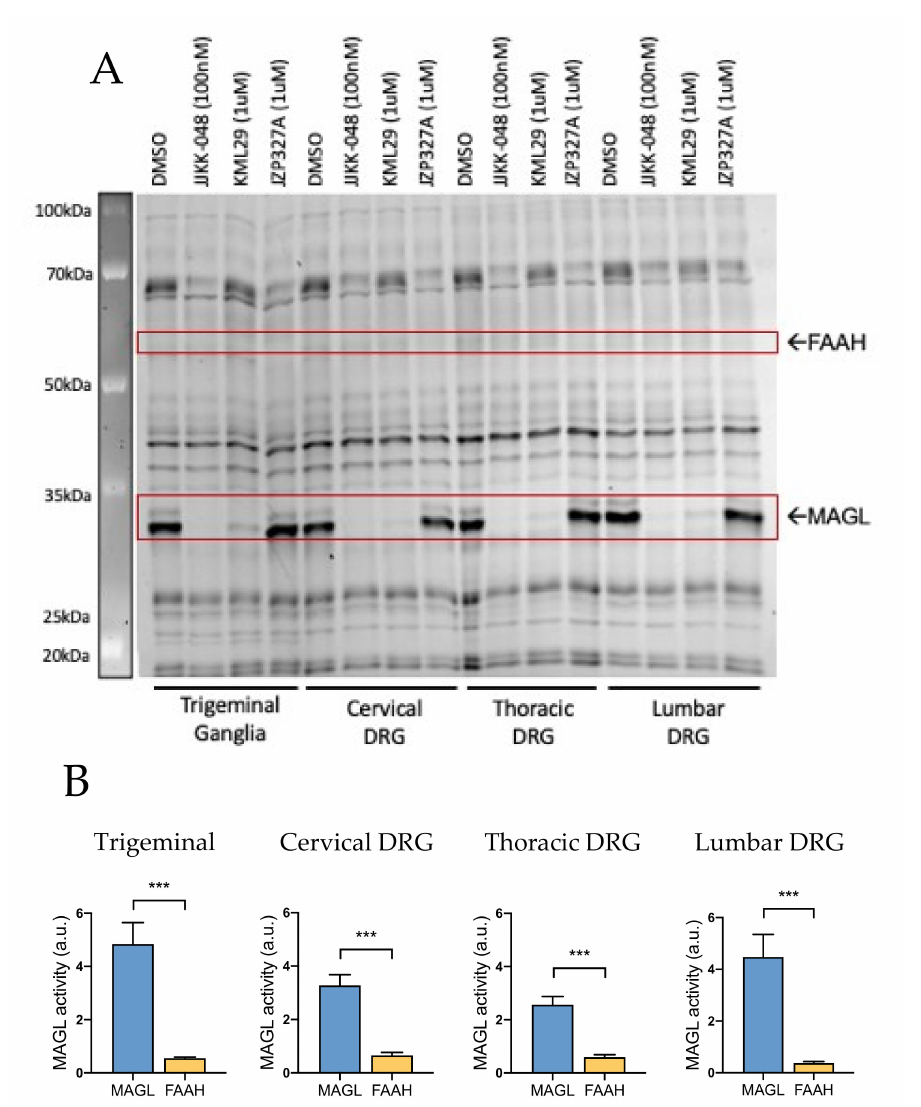
Figure 1. Competitive gel-based activity-based protein profiling (ABPP) reveals higher monoacyl- glycerol lipase (MAGL) activity over fatty acid amide hydrolase (FAAH) in trigeminal ganglia (TG) and cervical, thoracic and lumbar dorsal root ganglion (DRG). ( A ) Rat TG and DRG proteomes were preincubated for 1 h with vehicle (DMSO), the MAGL-inhibitors JJKK-048 (100 nM) and KML29 (1 µ M) and FAAH-inhibitor JZP327A (1 µ M). Then they were labeled with the fluorescent probe TAMRA-FP, as indicated in Materials and Methods. TAMRA-FP labeled bands (active serine hy- drolases) appear dark after in-gel imaging. FAAH and MAGL were identified based on selective inhibition and their expected molecular weights. Notice that MAGL activity after DMSO treatment is high whereas the FAAH activity was almost absent. ( B ) Histograms comparing the basal activity of MAGL and FAAH in TG and DRG. Basal MAGL activity was approximately 9-fold higher compared that of FAAH in TG (in a.u., arbitrary units). Similarly, MAGL activity compared to that of FAAH was ~5-fold higher in cervical DRG, ~4-fold higher in thoracic DRG and ~11-fold higher in lumbar DRG. Unpaired t-test, *** p < 0.001, n =